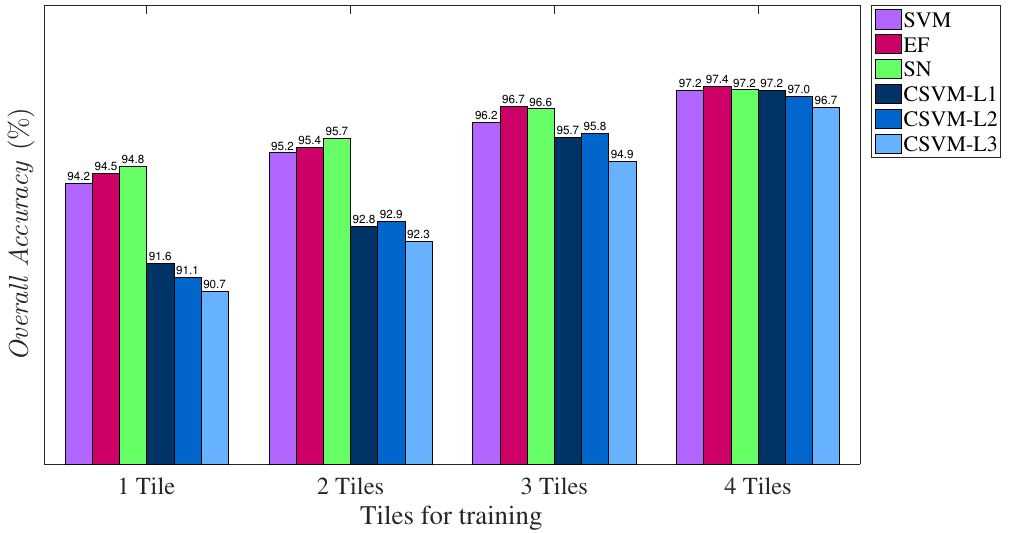
Figure 18. Overall Accuracy of Cerrado Biome obtained from SVM, EF, SN, and CSVM (after each layer) using one, two, three, and four tiles for